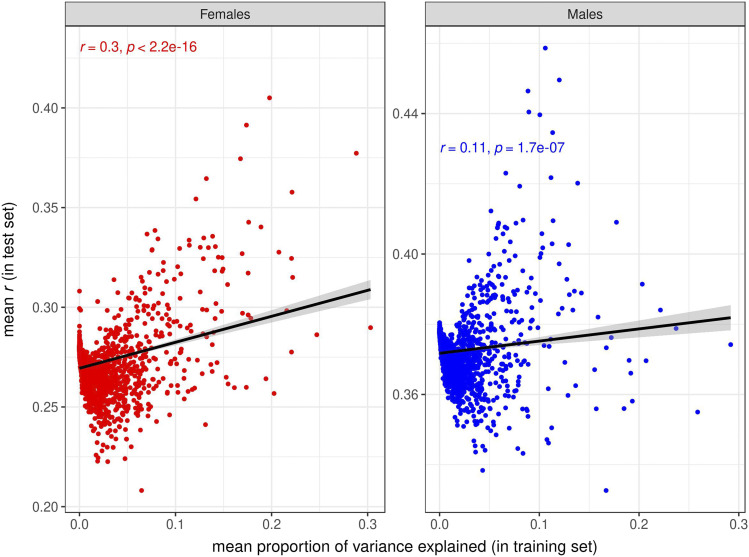
Relationship between prediction accuracy obtained by the GO-TBLUP model, measured as mean r in the test set (on the y-axis), and mean proportion of variance explained by the GO terms in the training set (on the x-axis), for starvation resistance. Each point represents a specific GO term. The black line represents the linear regression fit. The left panel represents females, and the right panel represents males.